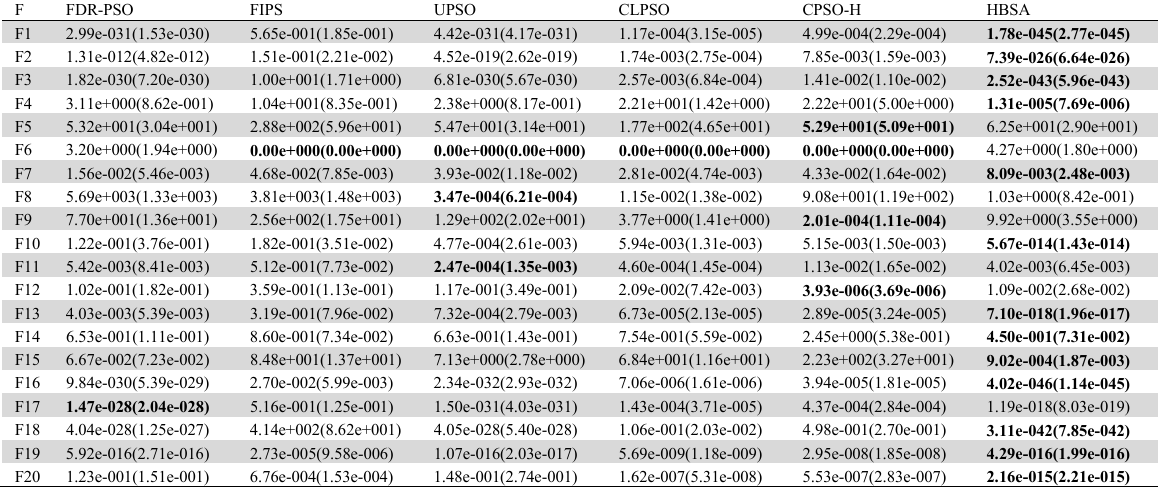
Comparison of statistical result of HBSA of error function value with different state of the art PSO variants F